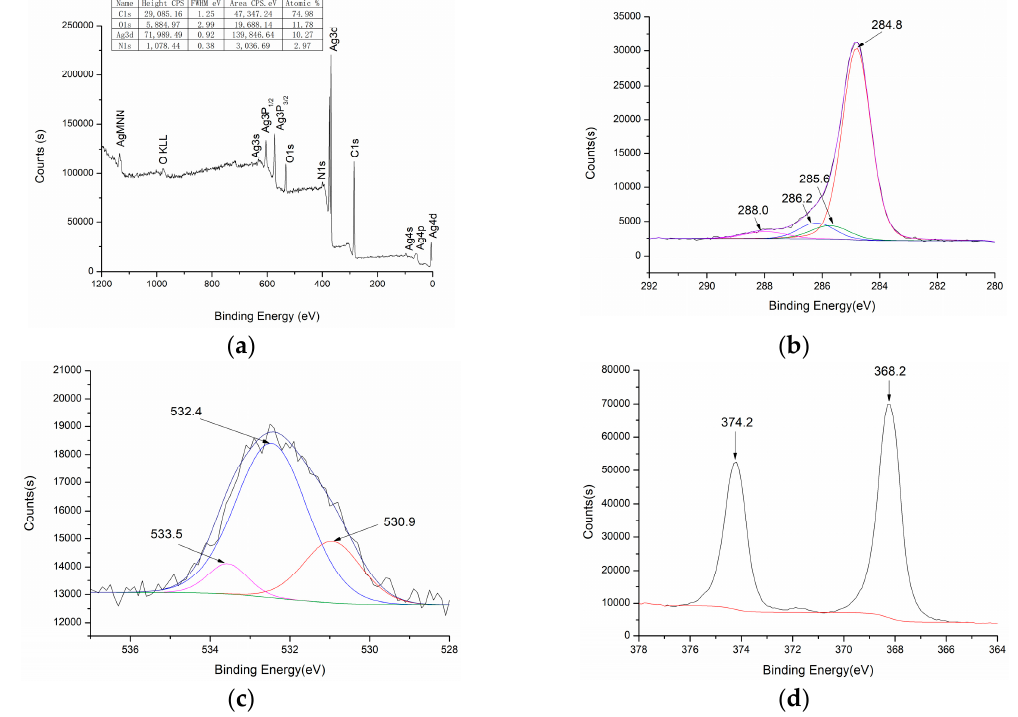
Figure 6. X-ray photoelectron spectroscopy of Ag coated nonwoven polypropylene (3#): ( a ) full spectrum, ( b ) C1s peak, ( c ) O1s peak, and ( d ) Ag3d peak.